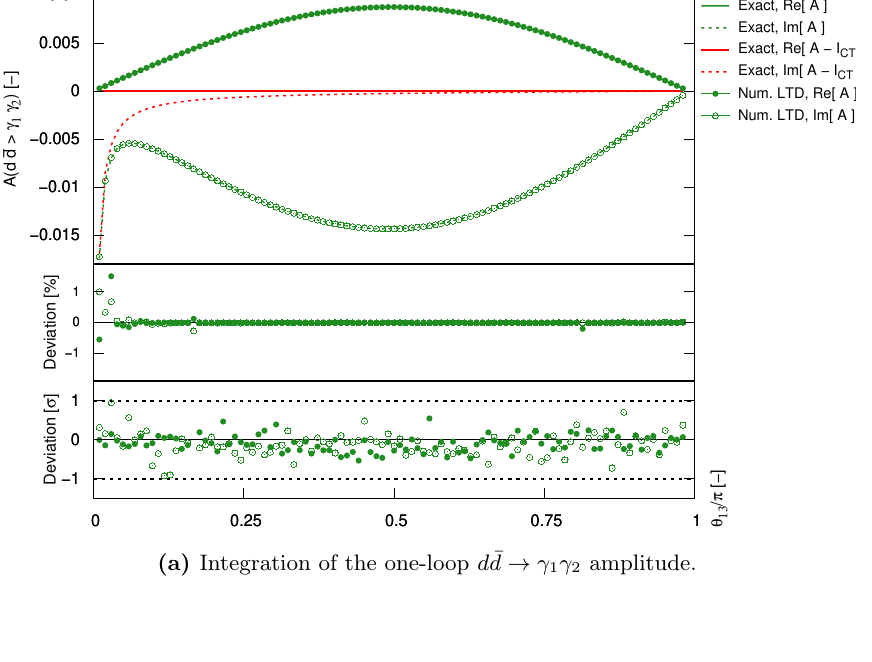
(cid:13)(cid:13) amplitude for various !